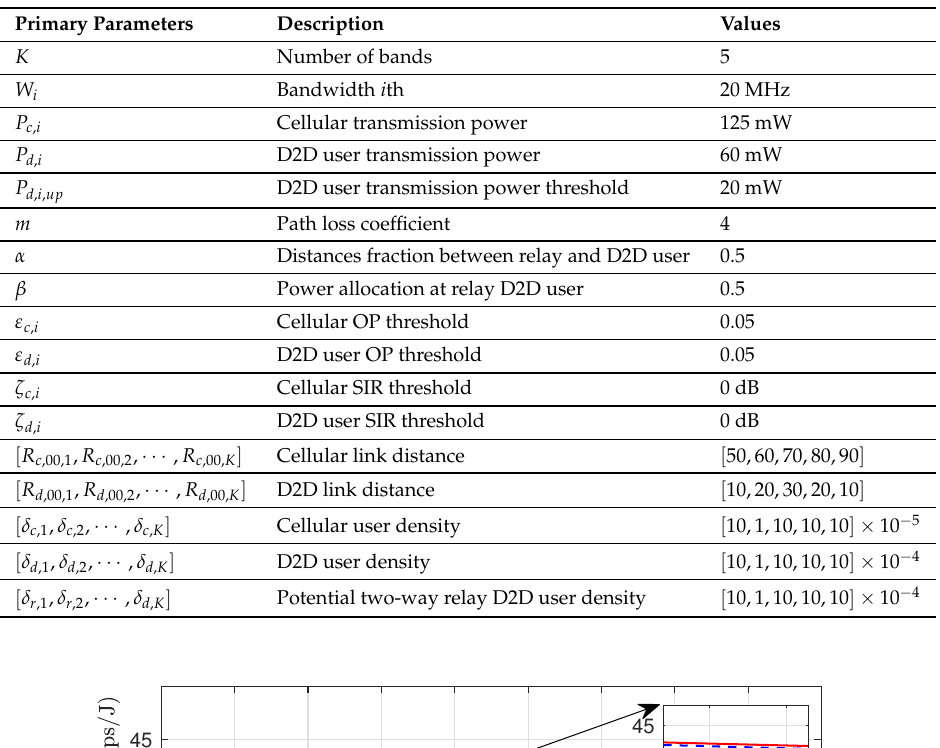
Table 1. Simulation parameters.